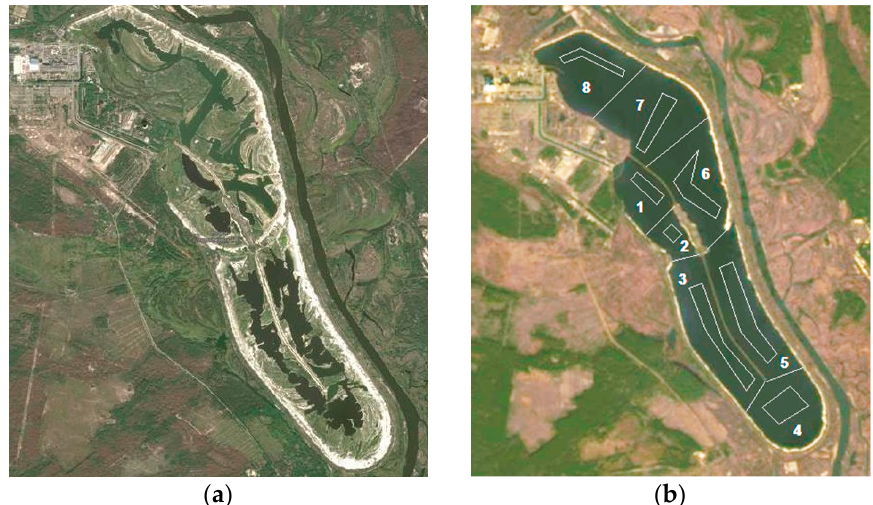
Figure 2. Satellite image of the CP in 2020 after water level drawdown ( a ) and schematic representation of the box system describing the CP in eight sectors connected and disconnected before and after the CP drawdown, respectively ( b ).